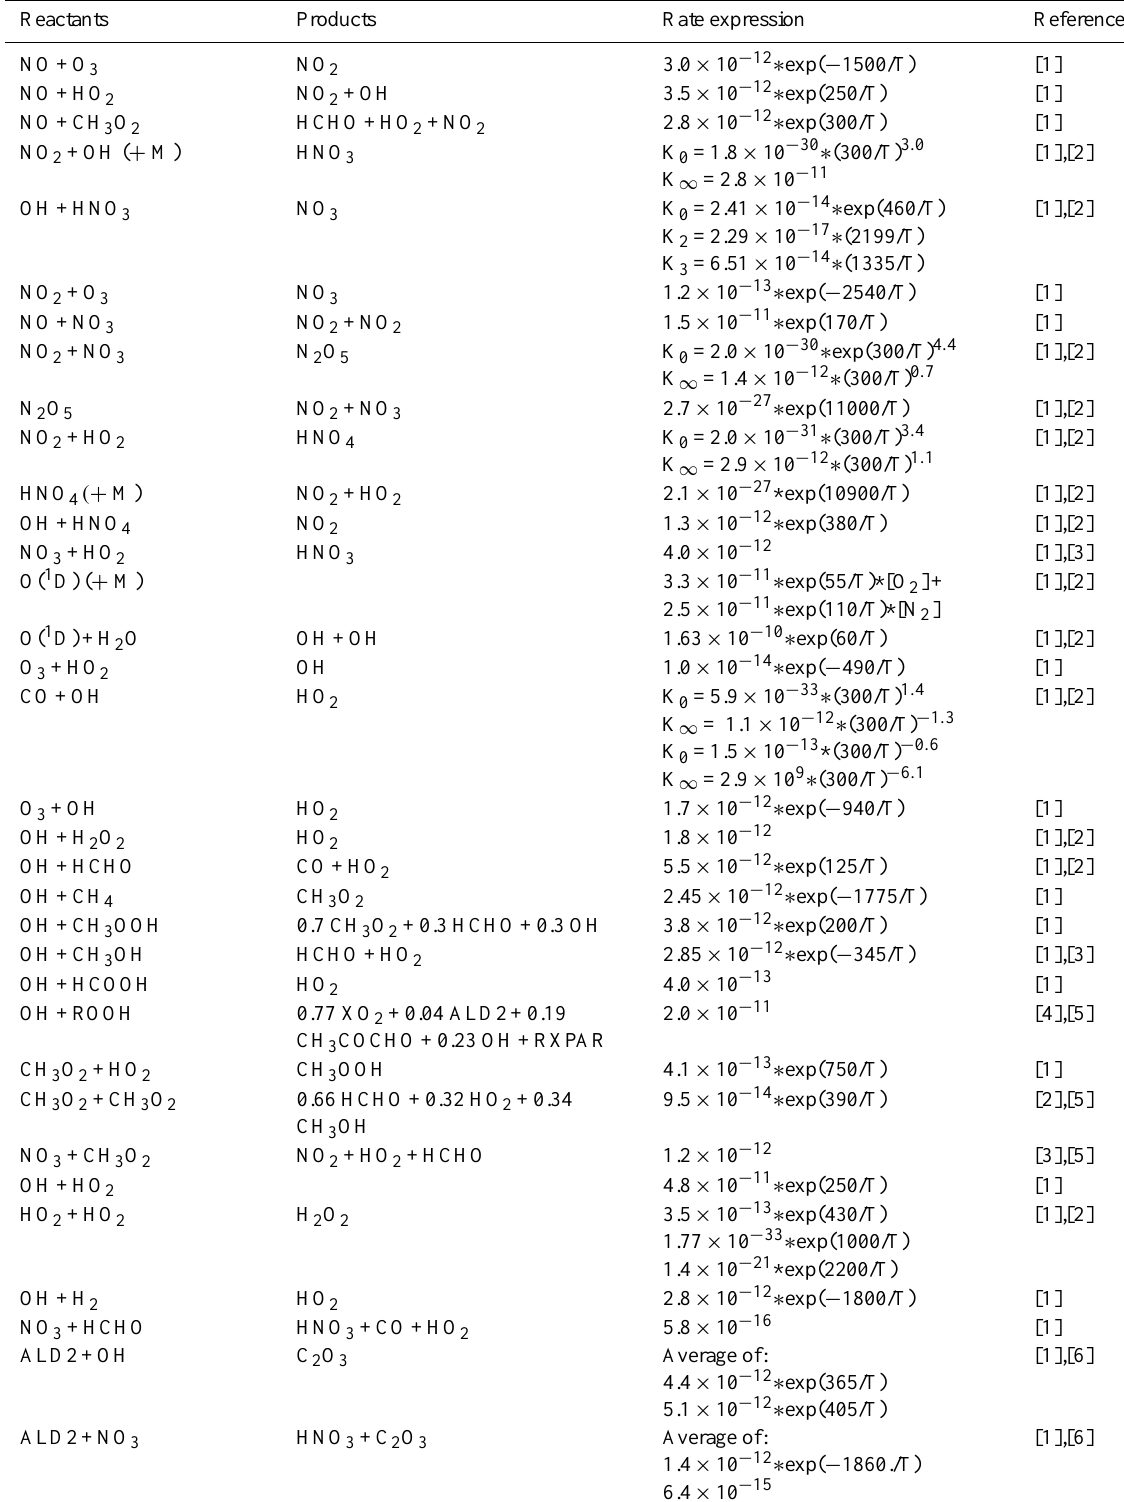
Table A1. A comprehensive description of the modified CB05 chemical mechanism. The reaction products O 2 and H 2 O are not shown. The sources of the reaction stoichiometry and chemical reaction data is thus: [1] Yarwood et al. (2005), [2] Sander et al. (2011), [3] IUPAC datasheet (www.iupac-kinetic.ch.cam.ac.uk), [4] Archibald et al. (2010), [5] Zaveri and Peters, (1999), [6] Atkinson et al.